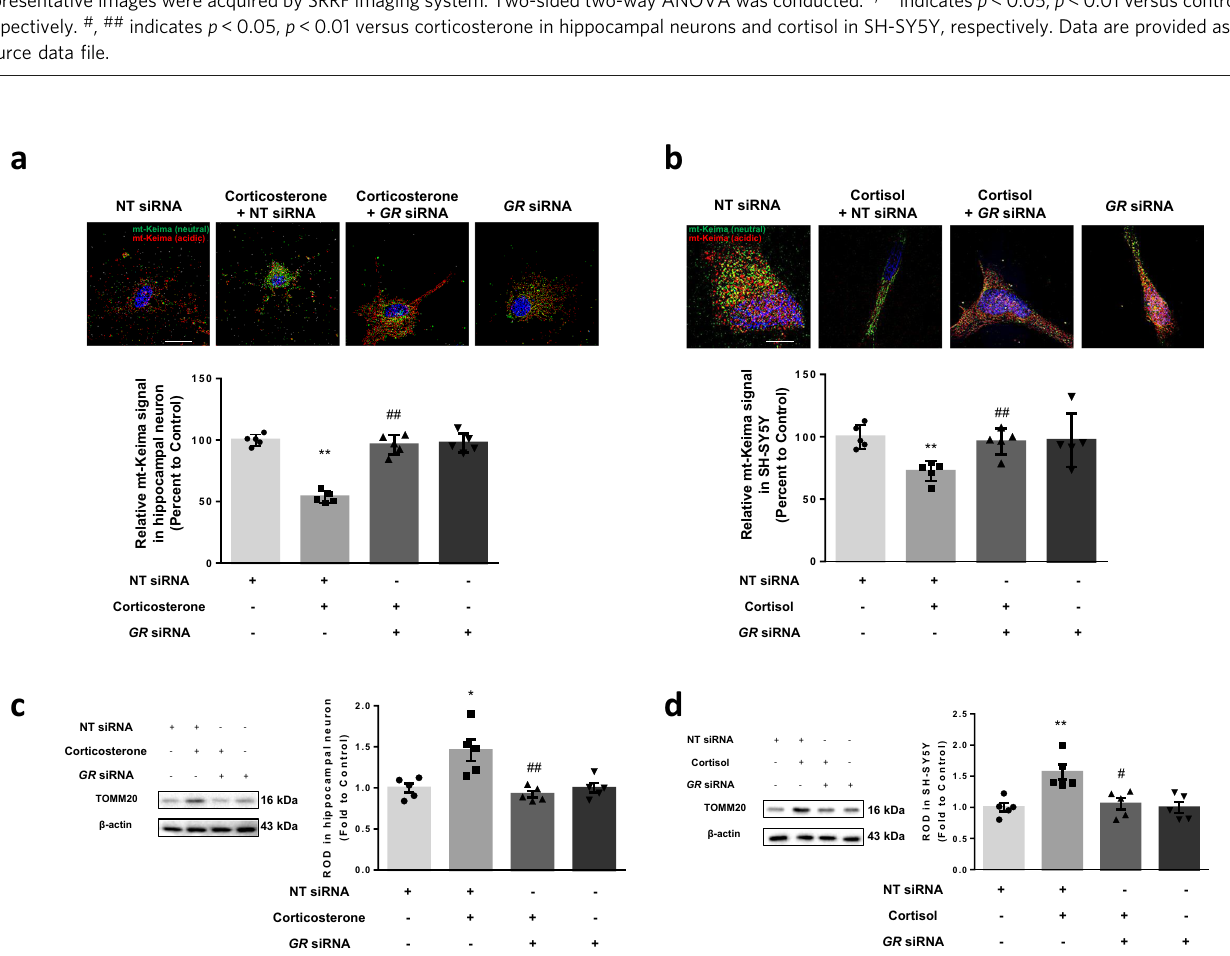
Fig. 5 GR-dependent inhibition of mitophagy. a – d Nontargeting (NT) or GR siRNA was transfected to hippocampal neurons and SH-SY5Y cells for 24 h prior to corticosterone and cortisol for 24 h, respectively. a , b Hippocampal neurons were transfected with mitochondria-targeted Keima (mt-Keima) at DIV 5, whereas SH-SY5Y cells were transfected with mt-Keima 48 h prior to treatment. Green and red fl uorescence of mt-Keima were visualized. DAPI was used for nuclear counterstaining (blue). Ratio of red to sum of red and green was quanti fi ed. Scale bars, 20 μ m (magni fi cation, ×1000). n = 5. c – d TOMM20 levels were detected by western blot. Loading control is β -actin. n = 5. All blots and immuno fl uorescence images are representative. n = 5 from independent experiments with two technical replicates each, respectively. Quantitative data are presented as a mean ± S.E.M. The representative images were acquired by SRRF imaging system. Two-sided two-way ANOVA was conducted. *, ** indicates p < 0.05, p < 0.01 versus control, respectively. # , ## indicates p < 0.05, p < 0.01 versus corticosterone in hippocampal neurons and cortisol in SH-SY5Y, respectively. Data are provided as a Source data fi le.